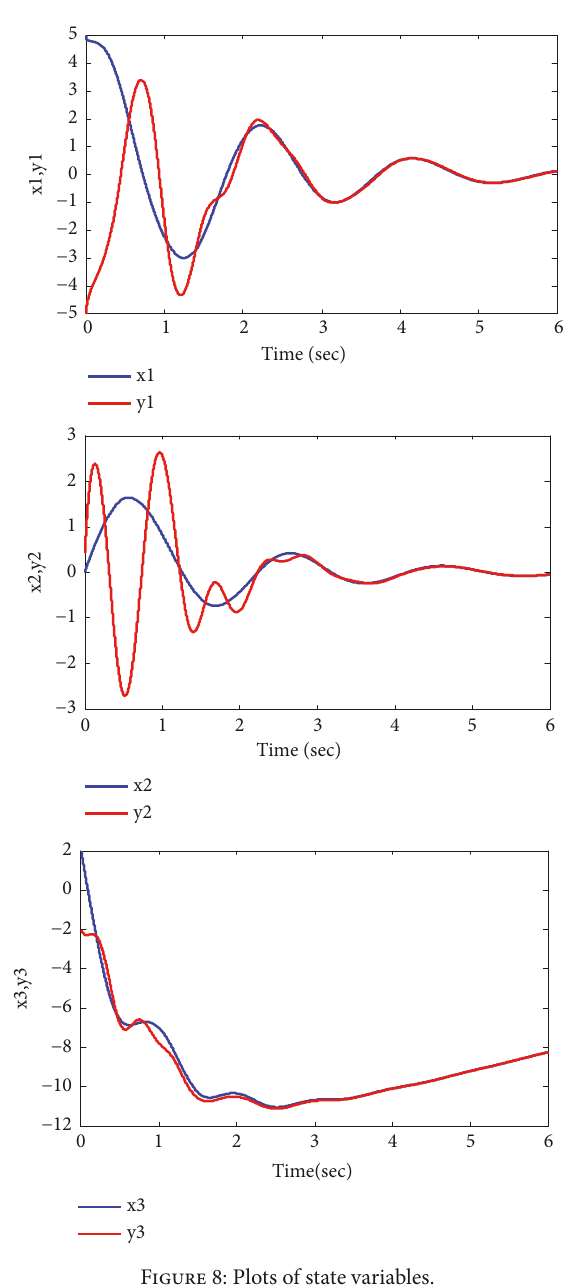
Figure 8: Plots of state